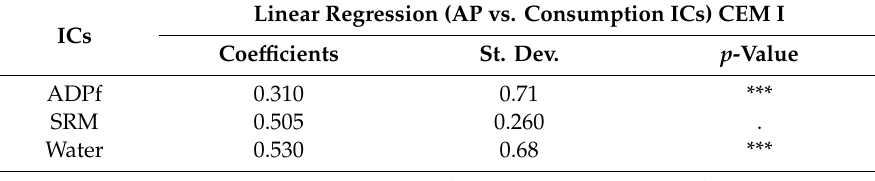
Table 22. AIC selection regression summary—CEM I.